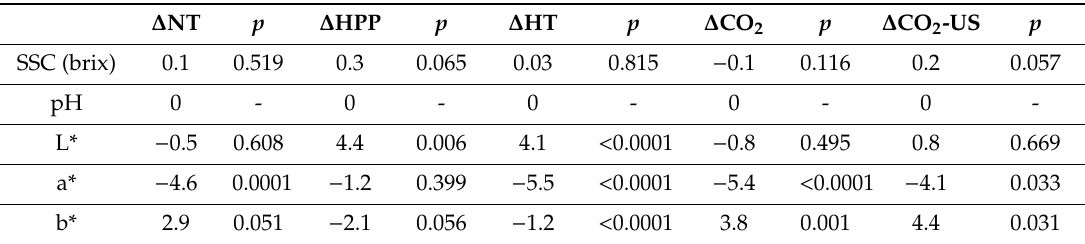
Table 4. Variation in soluble solid content (SSC), pH, and color parameters between pomegranate juices at t 0 and t 28 ( ∆ *), and ANOVA p -values ( p